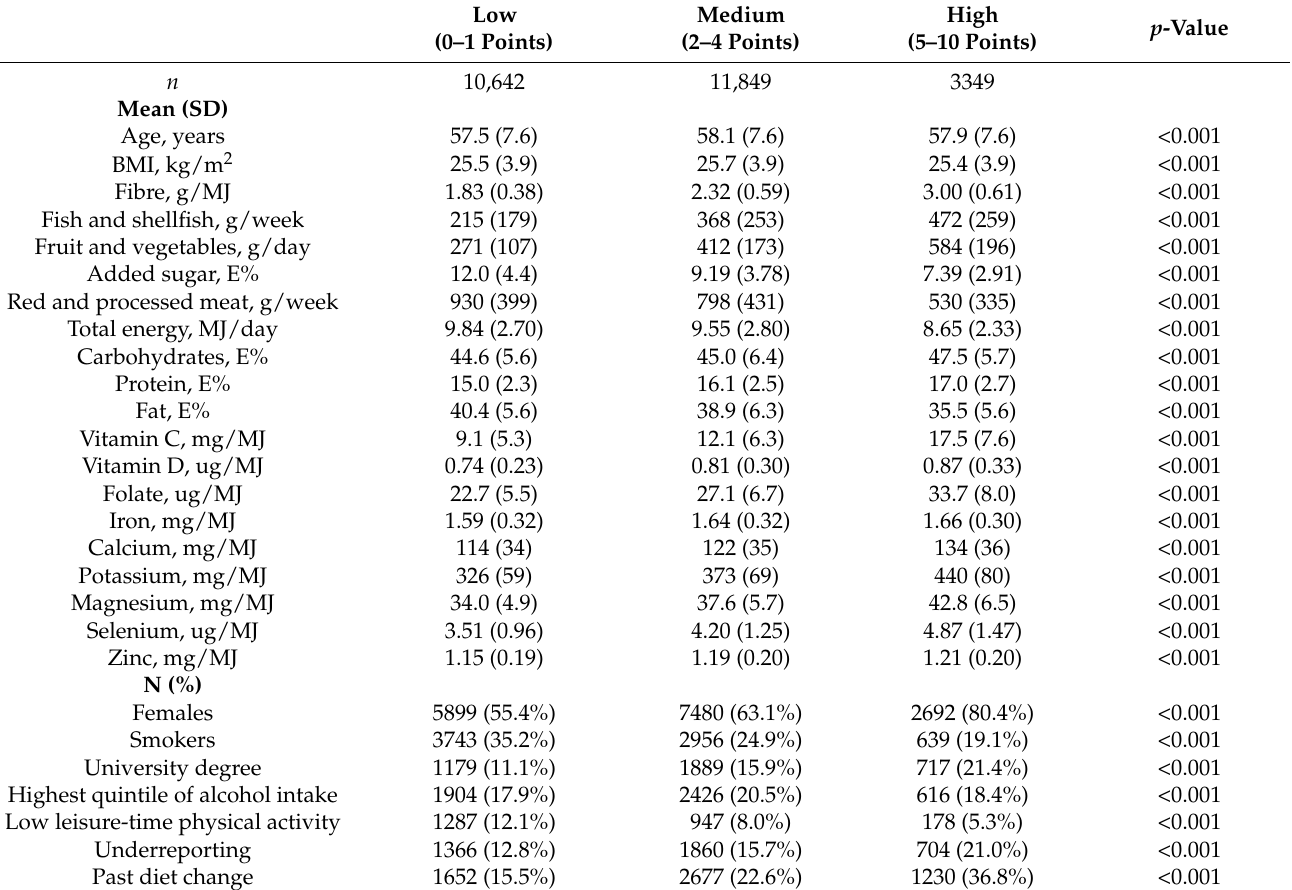
Table 1. Baseline characteristics across Swedish dietary guidelines score (SDGS) adherence